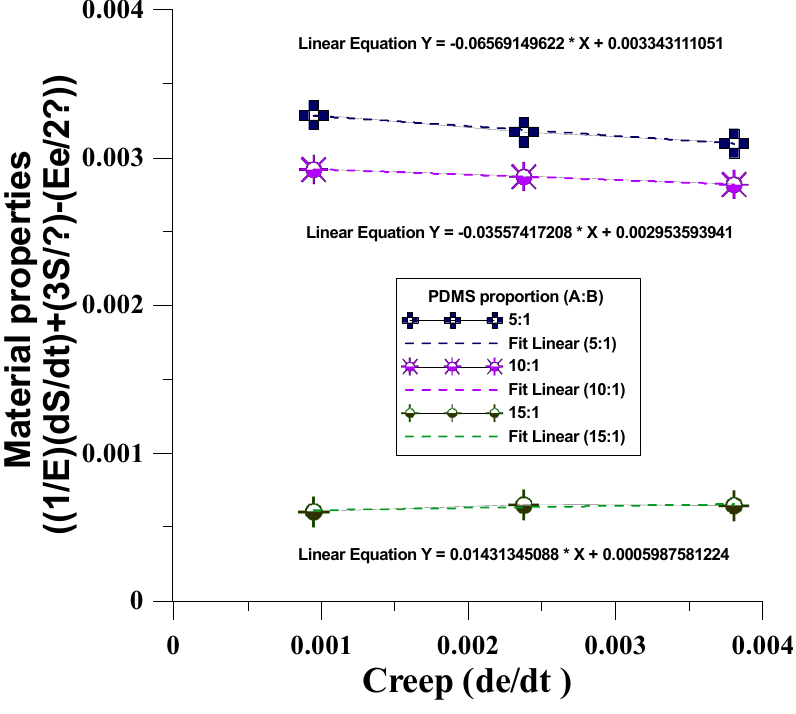
Figure 11. Time-dependent creep behavior of the dependent variables in the dynamic tensile g process of Model A.